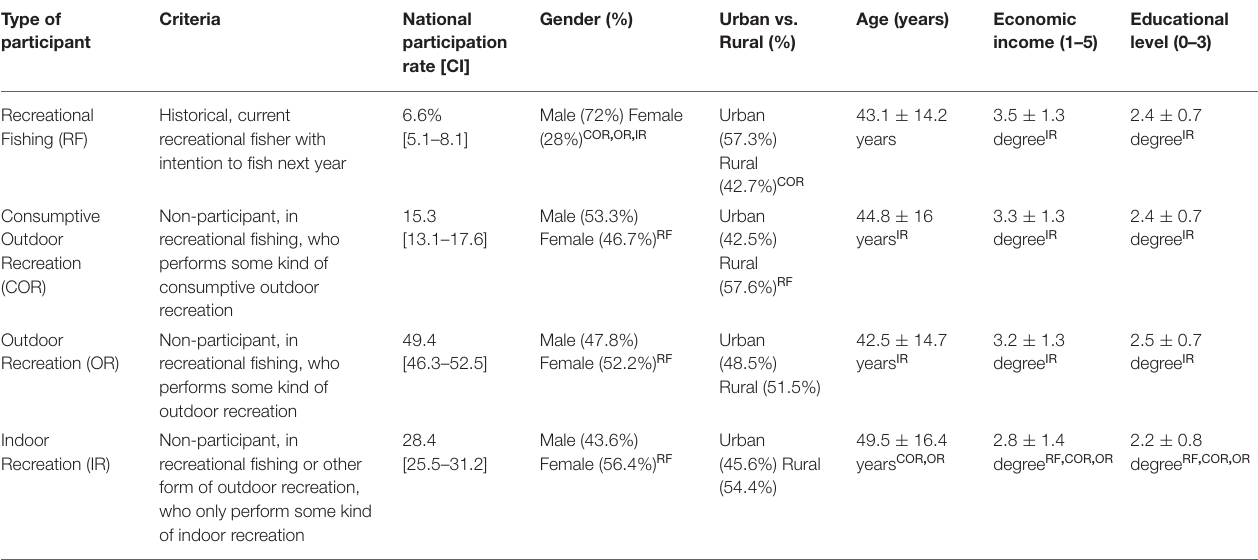
TABLE 2 | Criteria, participation rates (%) and social-economic attributes of the four profiles considered in this study regarding outdoor recreation (OR) and indoor recreation (IR). Type of